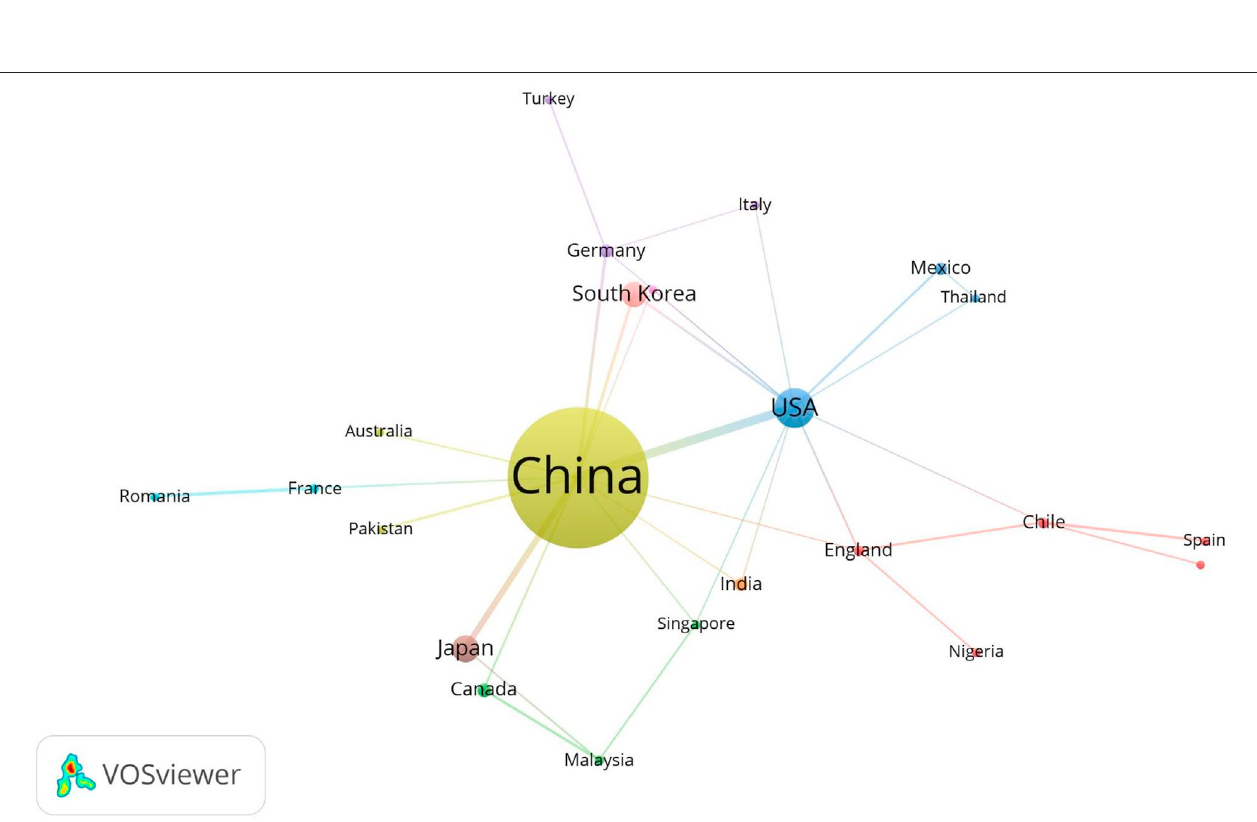
FIGURE5| Networkvisualizationmapofinternationalcollaborationamongcountries.Thethicknessoftheconnectinglinebetweenanytwocountriesindicatesthe strength of collaboration. Countries with similar colors form one cluster.